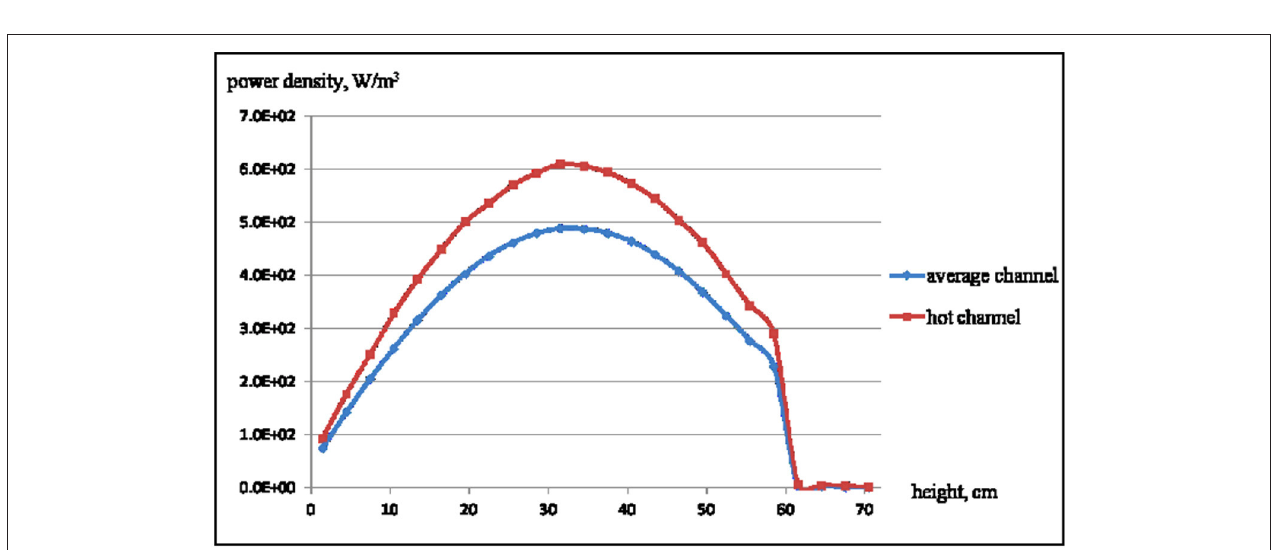
FIGURE 6 | Axial power density distribution of hot channel and average